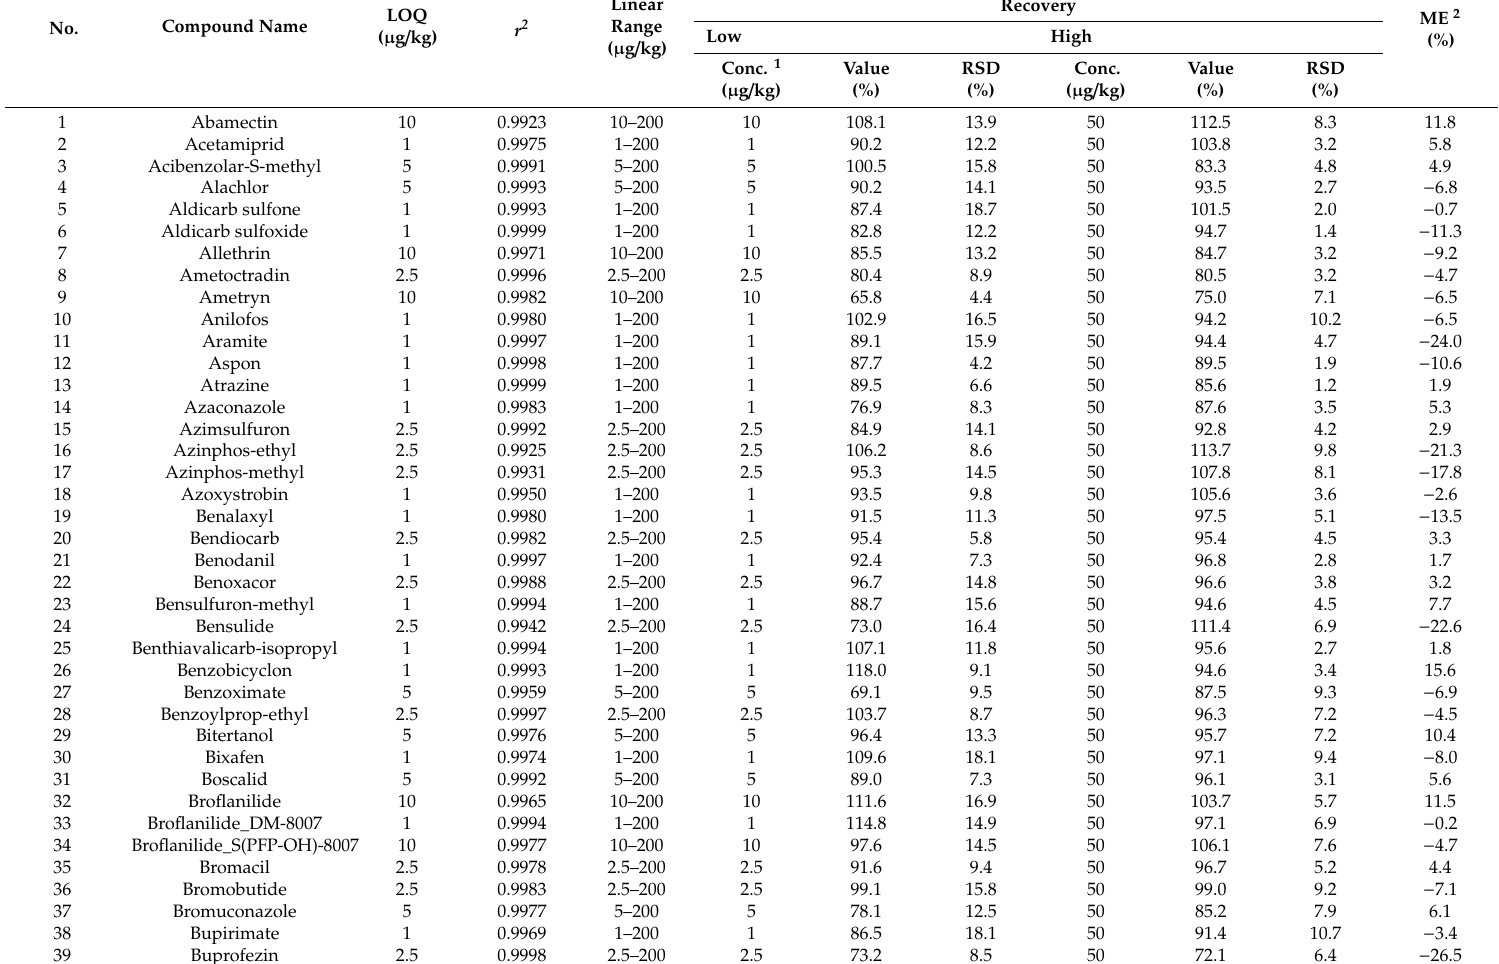
Table 3. Limit of quantitation (LOQ), linearity of calibration ( r 2 ), recovery, and matrix e ff ect validation results for the 353 target